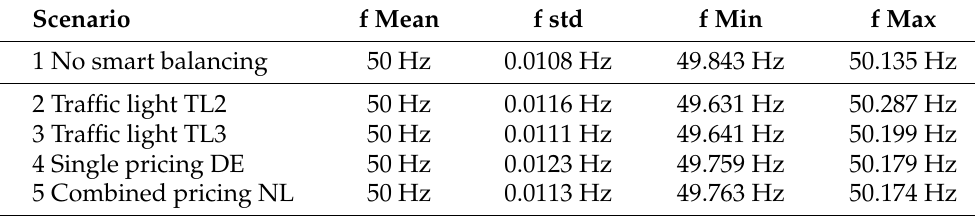
Table 9. Smart Balancing simulation - Results of scenarios with historic ACE and pay-as-bid clearing Table 9. Smart balancing simulation: results of scenarios with historic ACE and pay-as-bid